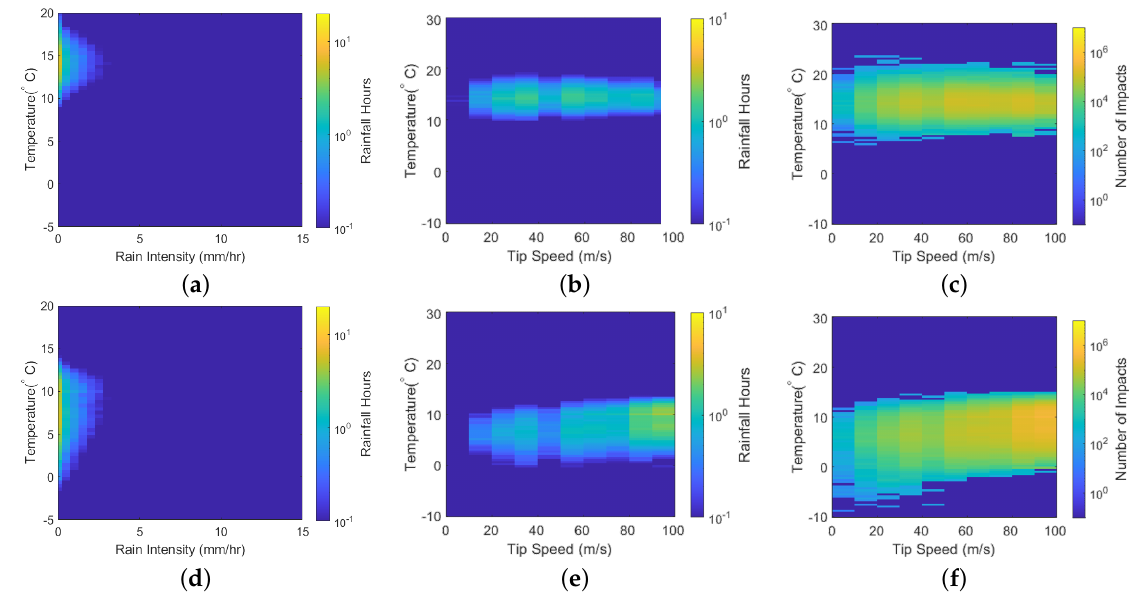
Figure 18. Average annual temperature/rainfall ( a , d ), temperature/rainfall/tip speed ( b , e ) and temperature/ n A /tip speed ( c , f ) distributions for July and December, respectively.